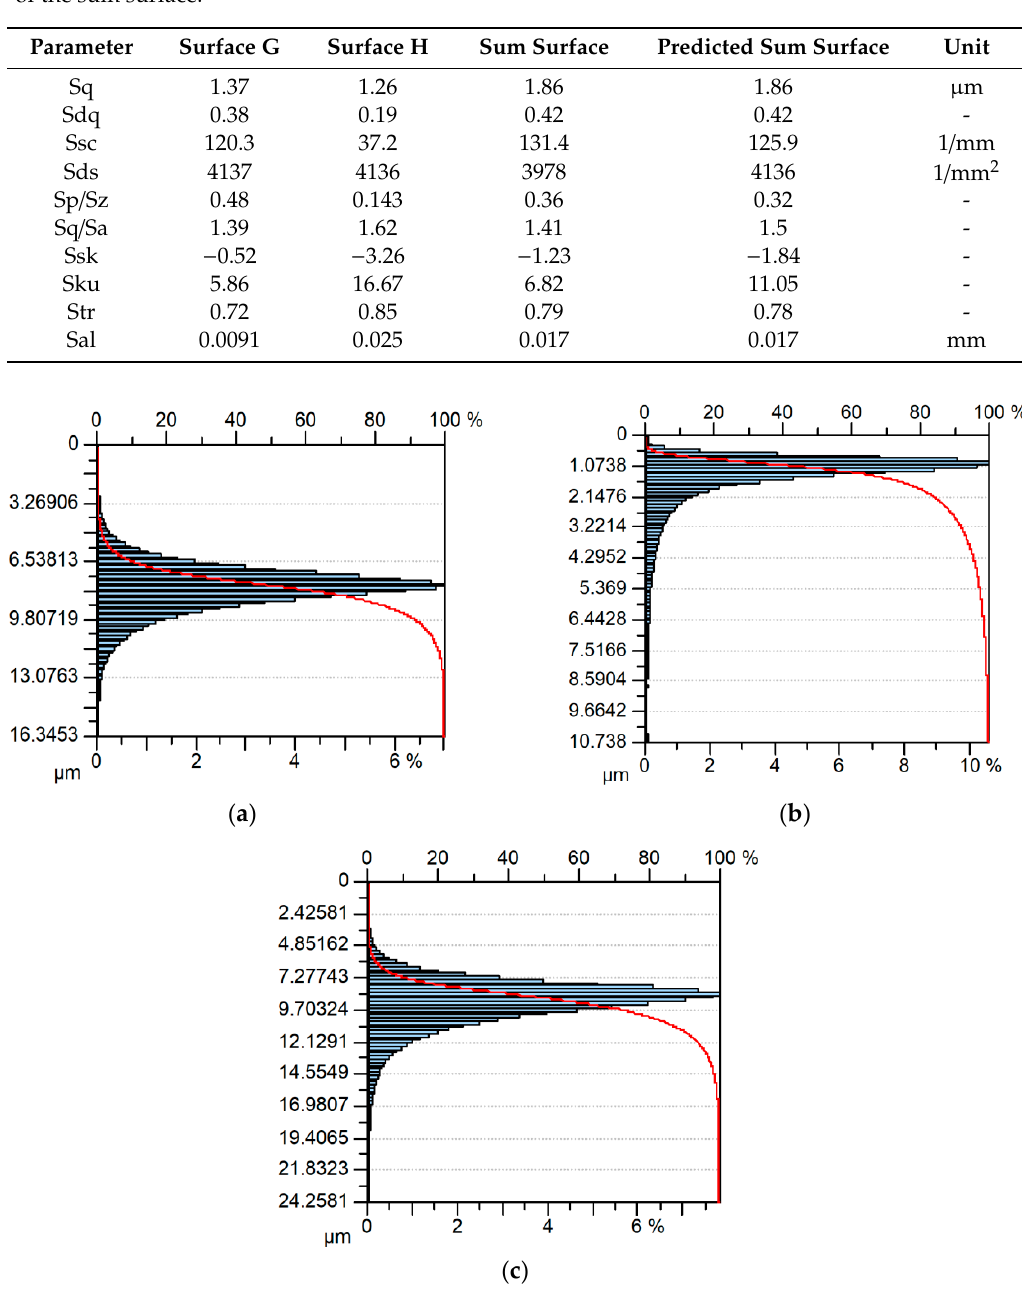
Table 6. Selected parameters of surface G, of surface H, of the sum surface, and of predicted parameters of the sum surface.